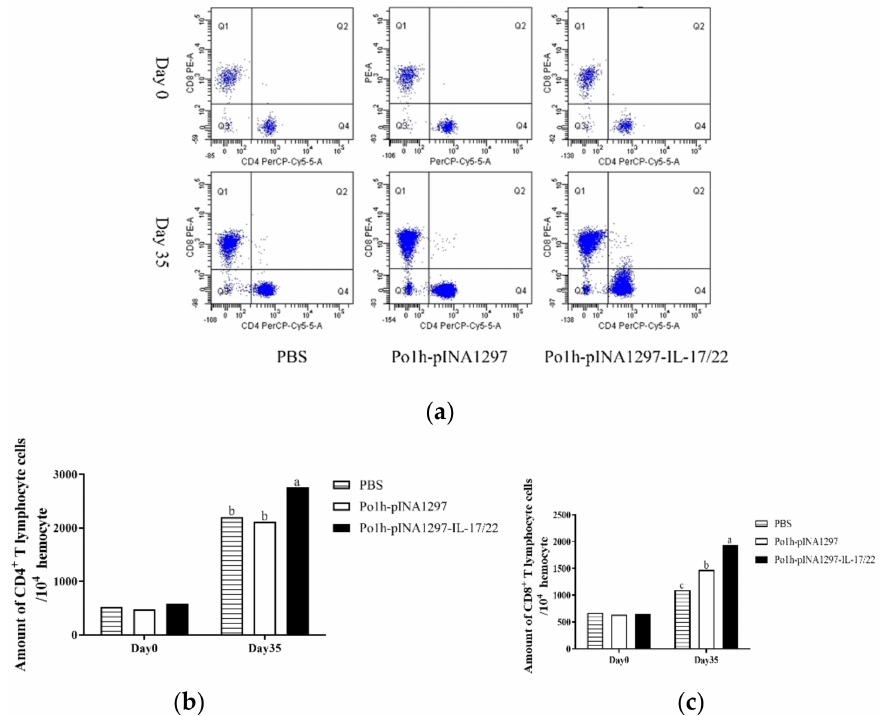
Figure 6. Changes in CD4+ and CD8+ T cells in the peripheral blood of mice on the 35th day post inoculation. ( a ) Changes in the CD4+ and CD8+ T cells. ( b ) The counts of CD4+ T cells. ( c ) The counts of CD8+ T cells. The data with different lowercase letters are significantly different, p < 0.05.